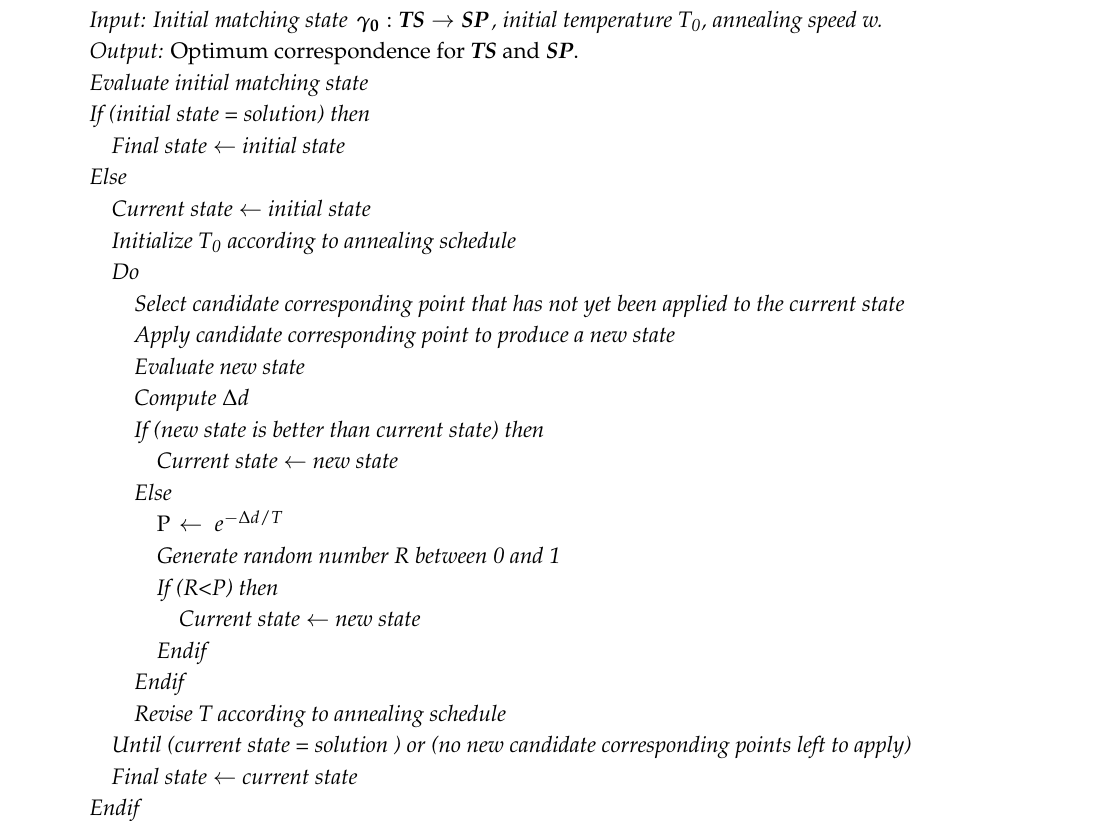
Algorithm 2 Correspondence of Characteristic Points by